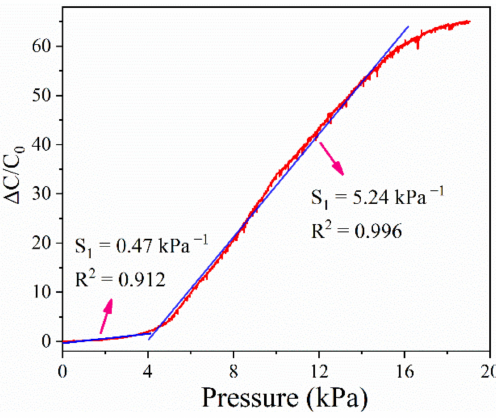
Figure 7. Response curves of pressure sensors under different